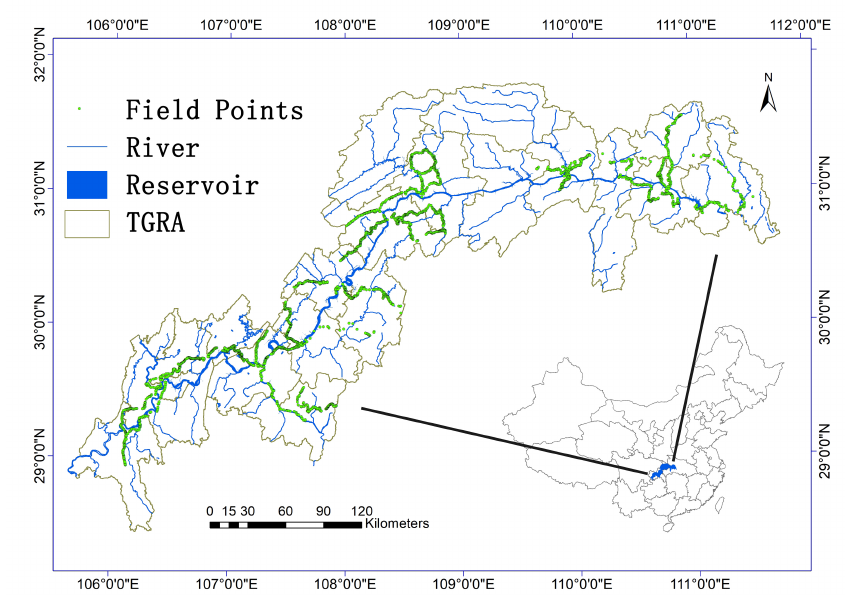
Figure 1. Location map of the TGRA. The green points show the ground-truth field points.